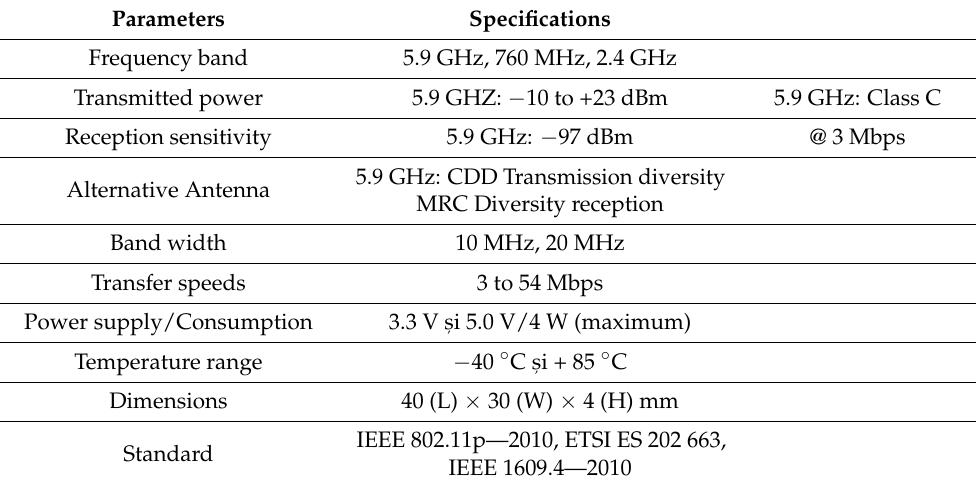
Figure 7. Mk5-OBU module architecture. Table 1. Features, parameters, and specifications of the MK5